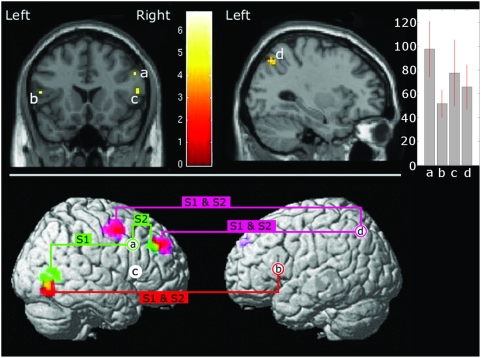
Parametric and connectivity imaging results.Top Panel: Primary Parametric Analysis: Coronal slice y = 18. Negative correlations to learning are seen in both left and right BA44, (a) xyz = 51 15 36, Z = 4.19, (b) xyz = −51 18 12, Z = 3.56, (Broca's Region) (c) xyz = 57 18 12, Z = 3.35. As well as in the inferior parietal lobule, shown on sagital slice x = −30, (d) xyz = −30 −69 48. Images generated at P<0.05 FWE and small volume corrected. Contrast of estimates & 90% confidence interval for each cluster given in bar chart on right. Lower Panel: Secondary Functional Connectivity Analysis: Four seed regions of interest identified by our initial parametric analysis (top panel) are marked as white circles. Clusters from PPI connectivity analysis derived from each seed are rendered onto the single subject MNI template brain with the colour coded key, red = left BA44 analysis; green = right BA44 analysis (dorsal); magenta = left inferior parietal lobule analysis. Yellow colouring in a cluster denotes locus of colocalization from two separate PPI analyses. “S1 & S2” indicates effects were seen across both sessions, “S1”/“S2” indicates the effect was observed in session 1or session 2 only.